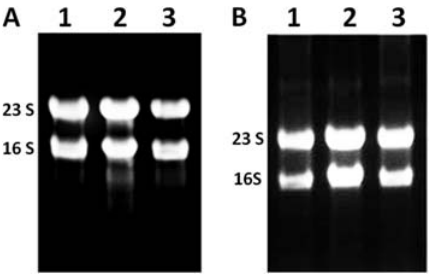
Figure 1. RNA that was obtained from the methicillin-resistant S. aureus (MRSA) isolate BMB9393, which was grown in the logarithmic ( A ) or stationary ( B ) phase using mechanical ( lane 1 ), enzymatic ( lane 2 ), and sheared whole-cell lyses ( lane 3 ).